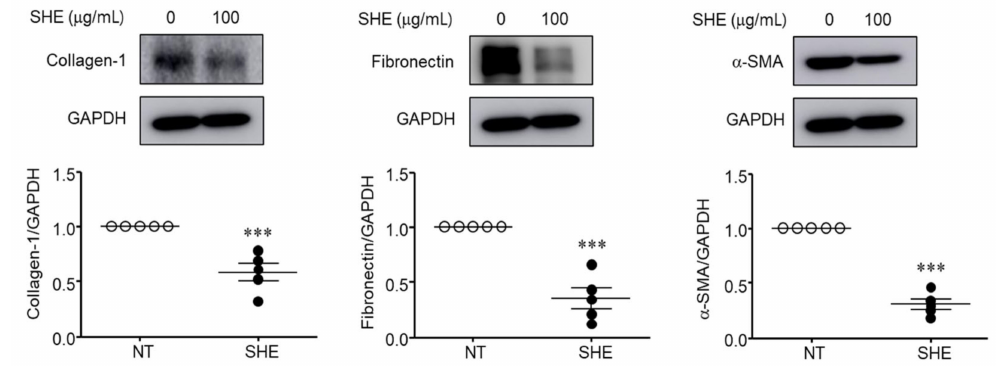
Figure 7. Effect of SHE on collagen-1, fibronectin, and α -SMA protein expression in NP tissues. The NP tissues were incubated with 100 µ g/mL of SHE using an air–liquid interface organ culture method. Following incubation with SHE for 24 h, collagen-1, fibronectin, and α -SMA protein expression level was assessed by western blotting. Each value indicates the mean ± SEM ( n = 5) and is representative of results obtained from three independent experiments. *** p < 0.001 vs. NT (no treatment